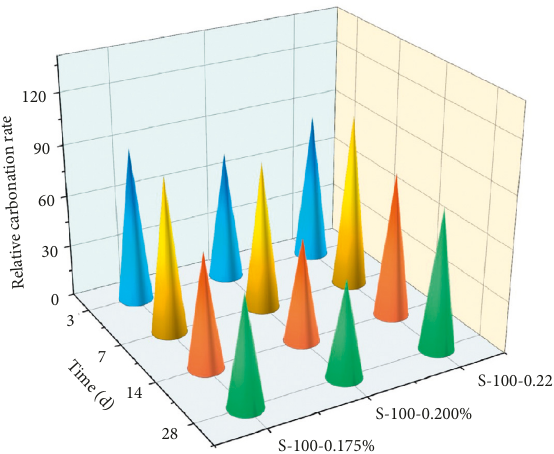
Figure 9: Relative carbonation rate of concrete with SAP of dif- ferent